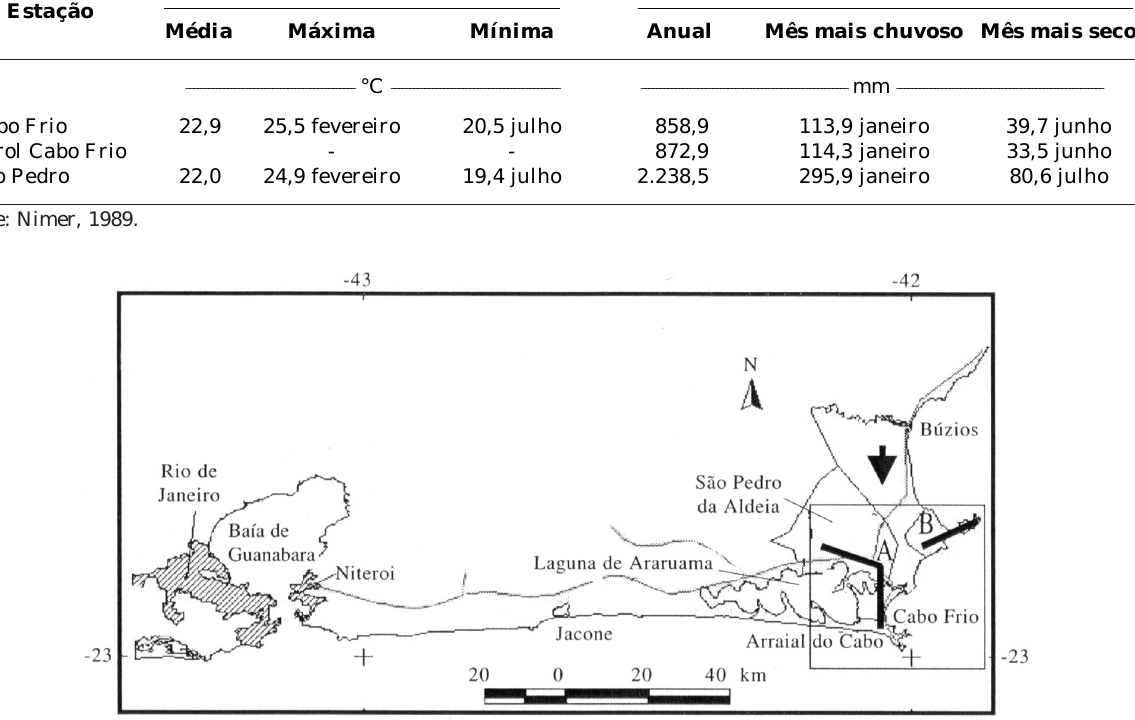
Figura 1. Localização da área estudada na Região dos Lagos, entre Cabo Frio/Búzios e Arraial do Cabo, com presença da Laguna de Araruama (RJ), ilustrando os transectos (A), Iguaba - Arraial do Cabo; e (B) Cabo Frio -